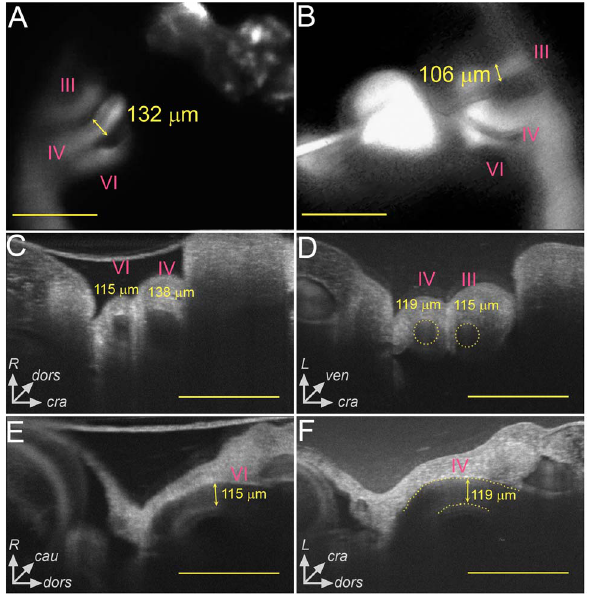
Figure 2. Multimodal imaging was used to obtain invivo AA diameter measurements in stage 21 chick embryos. Video recordings from fluorescent dye microinjections were processed to obtain individual AA identity and midpoint diameter data (A,B). OCT was used to obtain transverse (C,D) and longitudinal (E,F) sections through the AA to analyze midpoint diameter and AA tapering. Both the right (A,C,E) and left (B,D,F) laterals were imaged. In D, the dotted circles represent the AA lumen based on our image processing algorithm. The dotted lines in F highlight the boundaries of the AA lumen. Comparison between imaging modalities showed good agreement (p . 0.05). The axes in C-F demonstrate the dorsal (dors), ventral (ven), cranial (cra), caudal (cau), right (R), and left (L) directions to orient the reader. All scale bars are 500 m m.